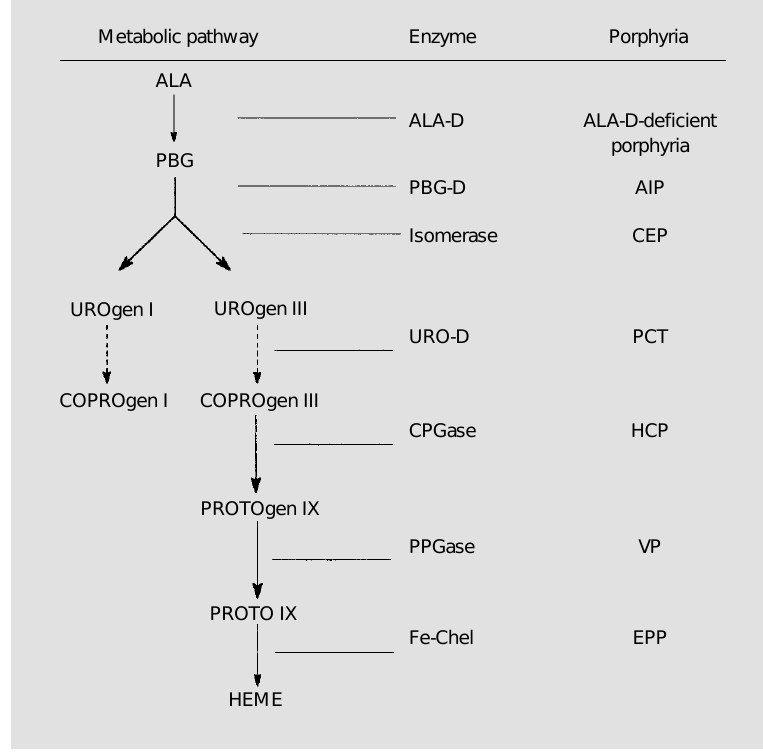
Figure 1 - Heme biosynthetic pathway. AIP: Acute intermittent porphyria; ALA: d -aminolev- ulinic acid; ALA-D: d -aminolevulinic acid dehydratase; CEP: congenital erythropoietic por- phyria; COPROgen: coproporphyrinogen; CPGase: coproporphyrinogen oxidase; EPP: eryth- ropoietic protoporphyria; Fe-Chel: ferrochelatase; HCP: hereditary coproporphyria; PBG: porphobilinogen; PBG-D: porphobilinogen deaminase; PCT: porphyria cutanea tarda; PPGase: protoporphyrinogen oxidase; PROTOgen: protoporphyrinogen; URO-D: